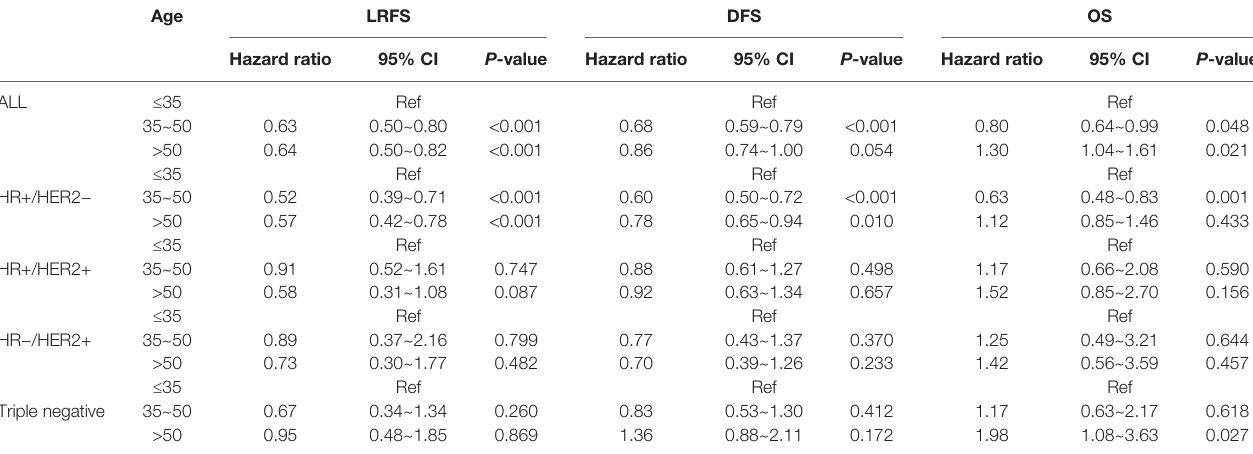
TABLE 2 | Analysis of the association between age and survival, adjusted for tumor molecular subtype.